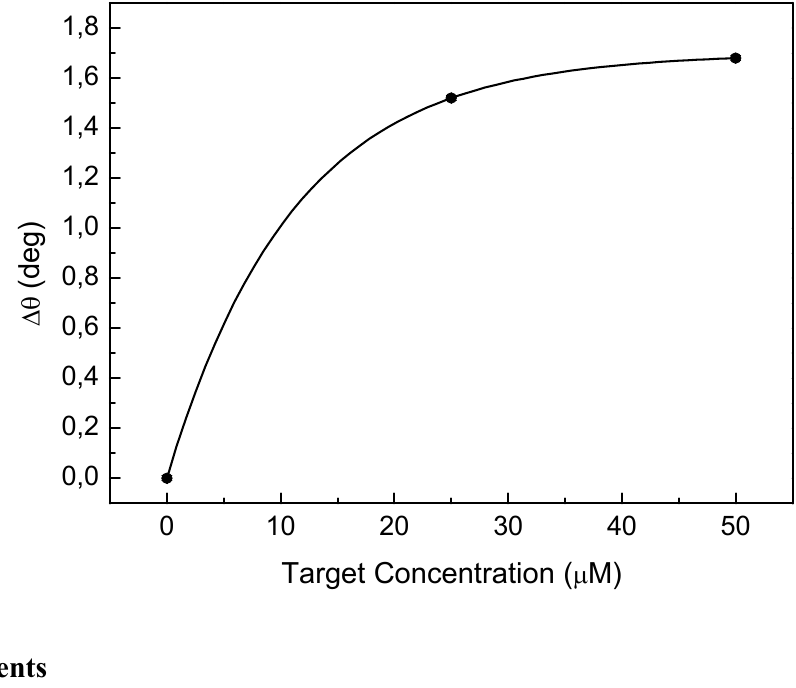
Figure 6. Resonance shifts of the waveguide mode coupling angle as a function of the DNA